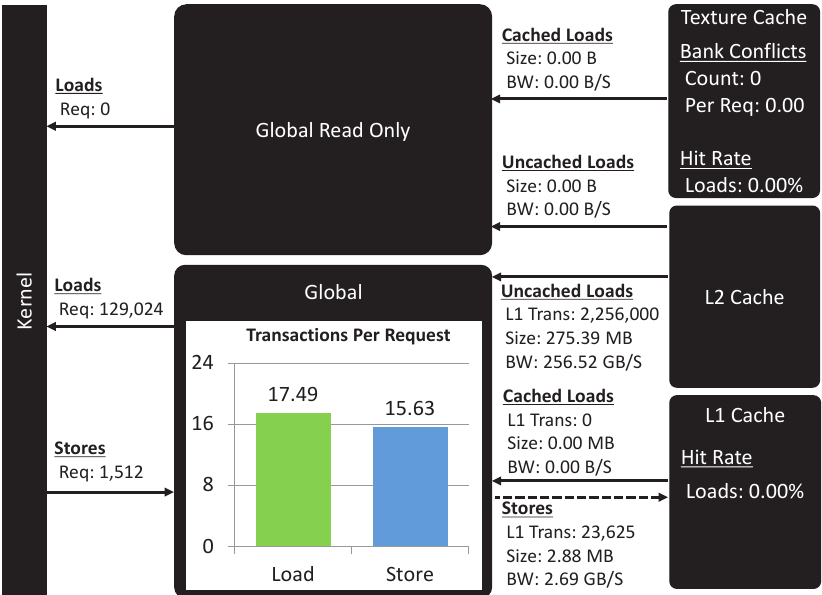
Figure 5. Memory statistics of Kernel A5. This is the comprehensive view of the interaction of Kernel A5 with the GPU’s memory subsystem. The main observations are the high number of transactions per request (ideal value 1 rather than the observed 17.49 and 15.63), and the 0% hit rate in the L1 Cache (ideal value close to